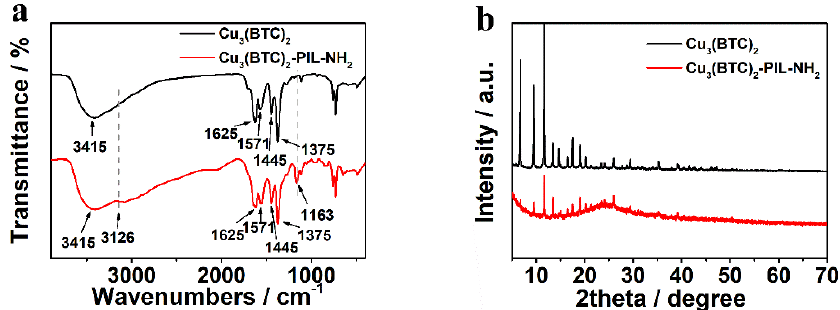
Figure 2. ( a ) FTIR spectra and ( b ) XRD patterns of Cu 3 (BTC) 2 and Cu 3 (BTC) 2 -PIL-NH 2 as indicated in the figure. Dashed lines in the FTIR spectrum are a visual guide.